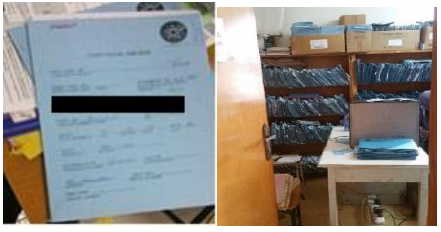
Figure 7 A blue folder holding patient records (Left).Patient folders on shelves behind the reception desk of the eye unit of JUMC (Right).